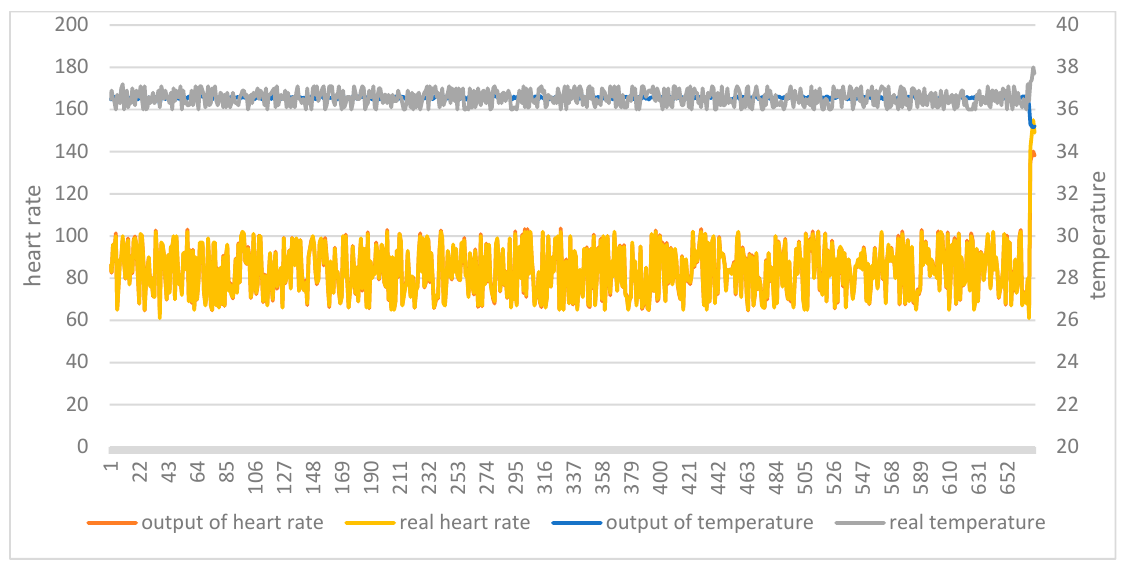
Figure 15. Comparison of input and output of GRU-AE model in test set 2.